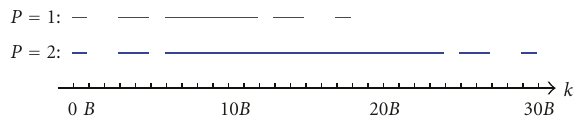
Figure 1: Support of the window functions g [ k ] representable by matrices W 0 ( z ), ... , W B − 1 ( z ) with maximal polynomial order P − 1 for J = 3, L = 4, P =